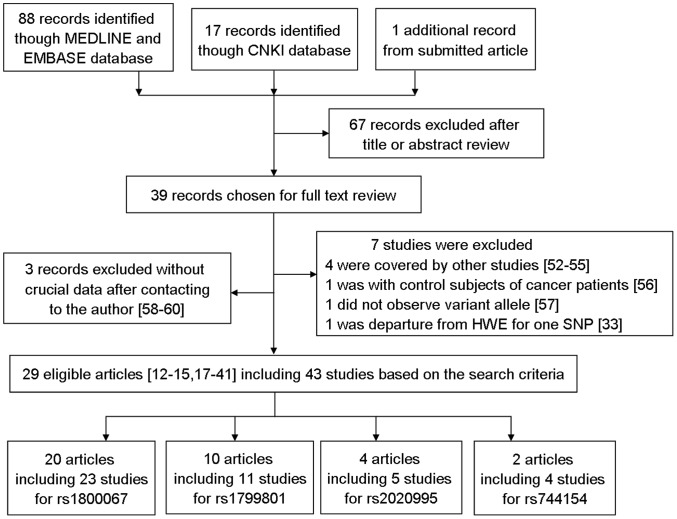
Flow diagram of included studies for this meta-analysis.